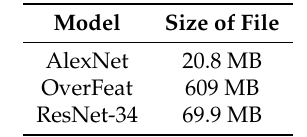
Table 2. Size of the imported